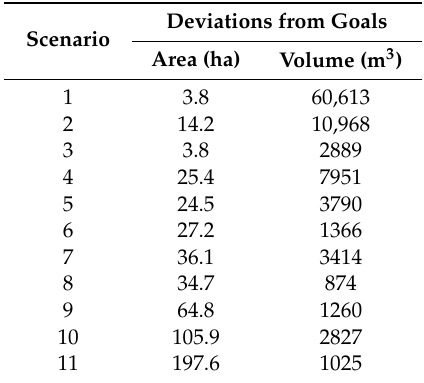
Table 4. Outcomes achieved using the linear regeneration model.